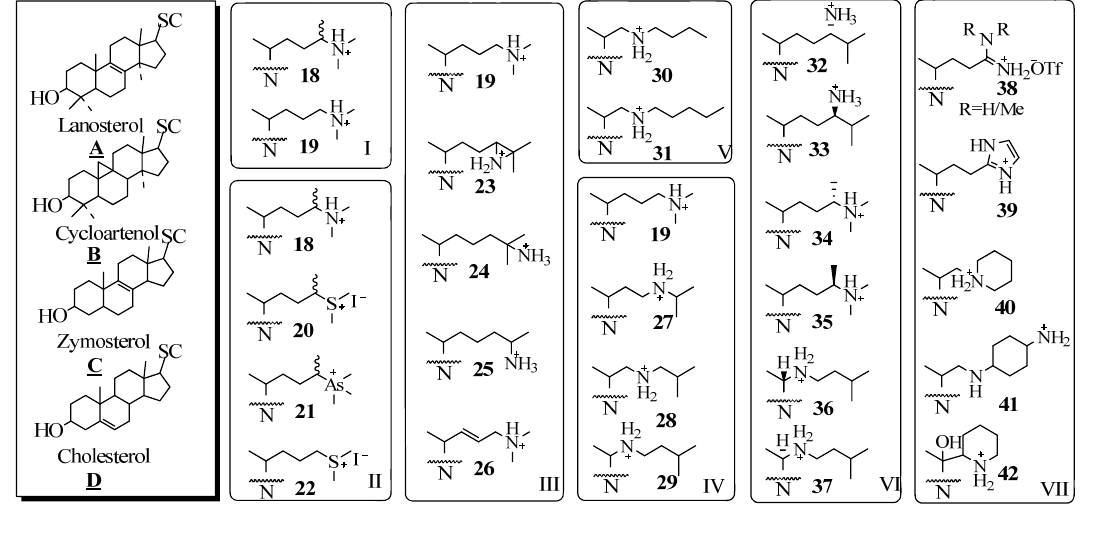
Figure 5. Preparative route to 25-azalanosterol A45